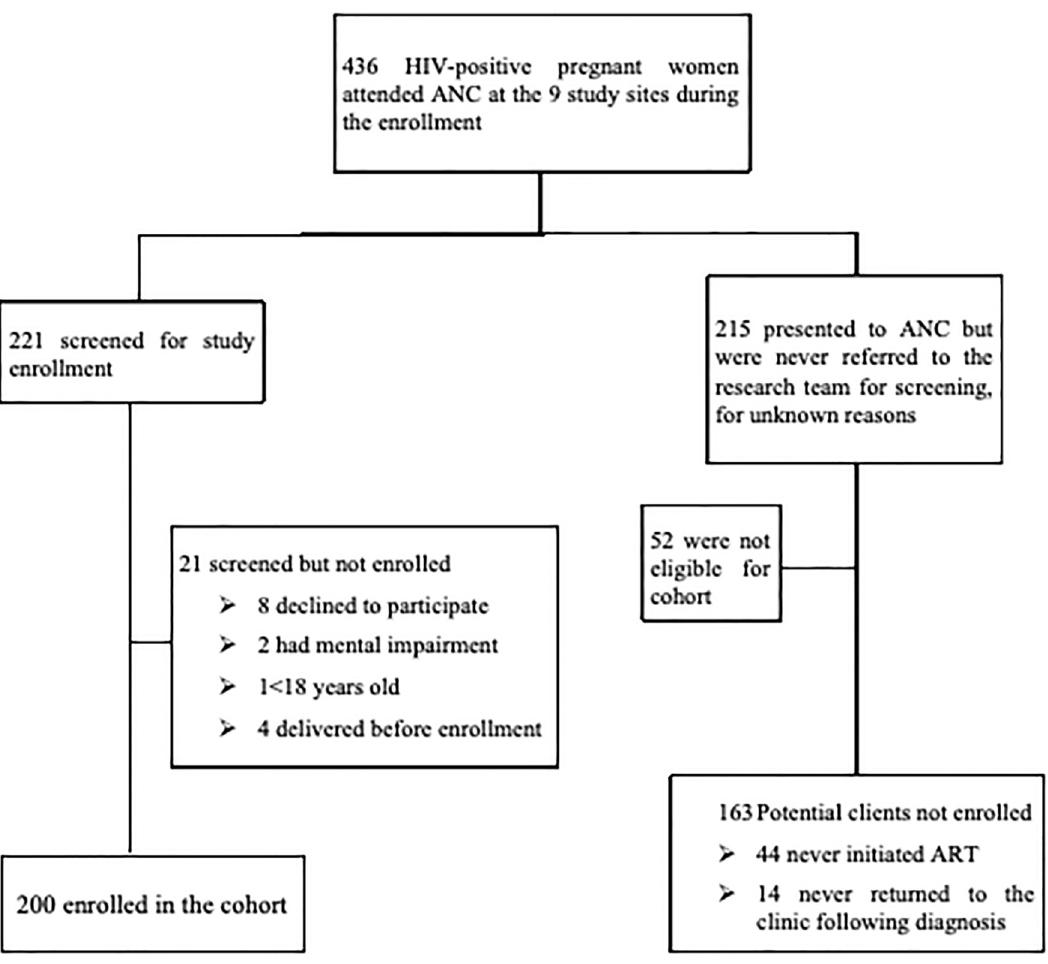
Fig 1. Participant screening and enrollment flow